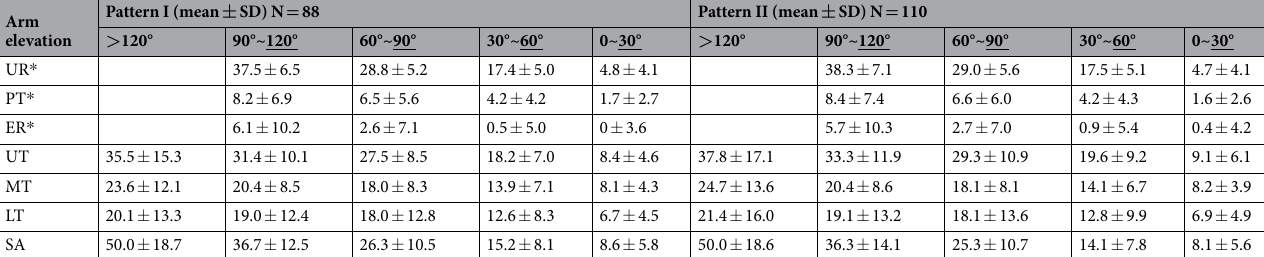
Table 1. Three-dimensional scapular kinematics and 4-muscle EMG data during lower phase of arm elevation in scapular plane. Pattern I: Inferior medial angle of the scapula is displaced posteriorly from the posterior thorax, prominent during dynamic observation and palpation; Pattern II: Entire medial border of the scapula is displaced posteriorly from the posterior thorax, prominent during dynamic observation and